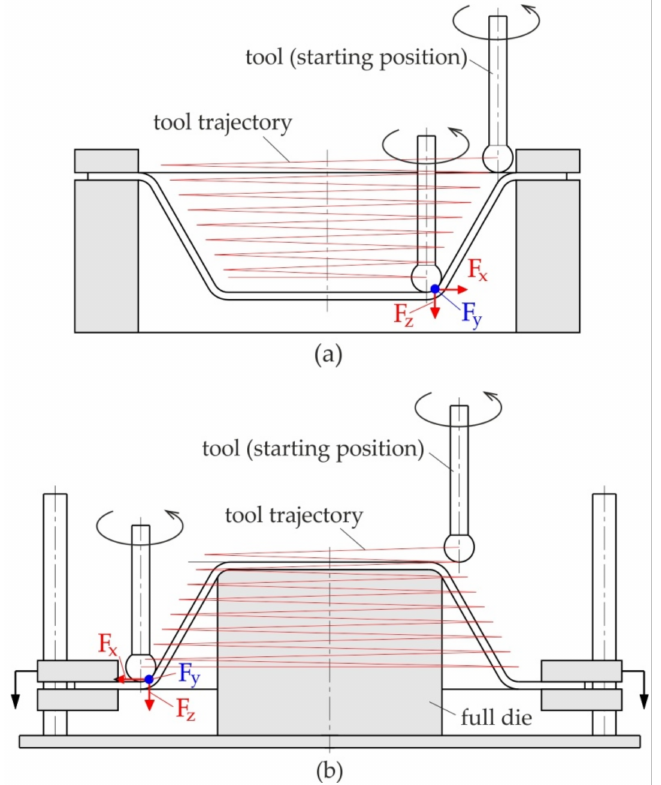
Figure 2. ( a ) Negative and ( b ) positive ISF.